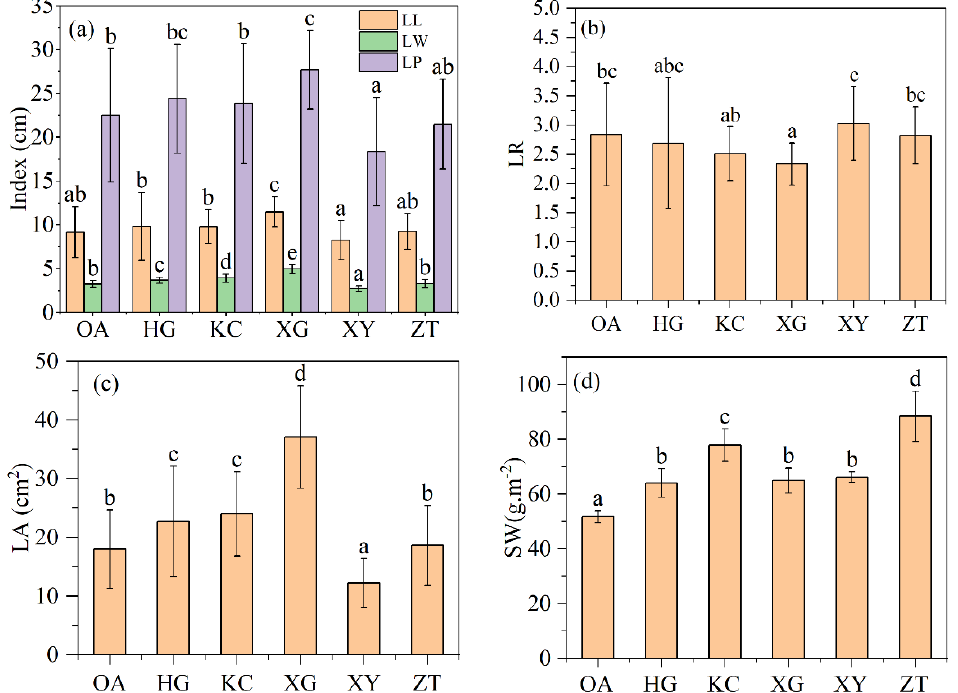
Figure 2. Leaf length, width and perimeter ( a ), Leaf length–width ratio ( b ), Leaf area ( c ), specific leaf weight ( d ) of Qi-Nan and OA. Different letters denote significant ( p < 0.05) differences among OA and the five Qi-Nan clones in a one-way ANOVA, and the bar represents standard deviation ( n = 5). “LL” leaf length; “LW” leaf width; “LP” leaf perimeter; “LR” leaf length-width ratio; “LA” leaf area; “SW” specific leaf weight.